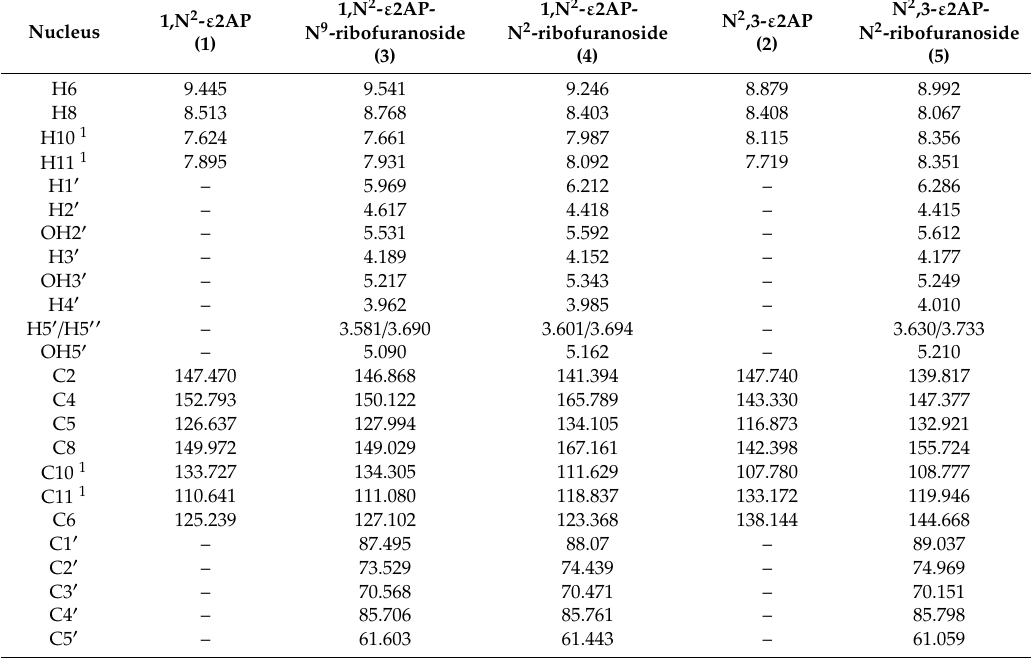
Table 2. 1 H- and 13 C-NMR chemical shifts in parts per million ( ± 0.001) of the etheno derivatives of 2-aminopurine ( ε 2AP) and their β - d -ribosides (see Materials and Methods for details). Chemical shift labels follow the naming convention of [28], extended for the etheno protons (see Figure 1).